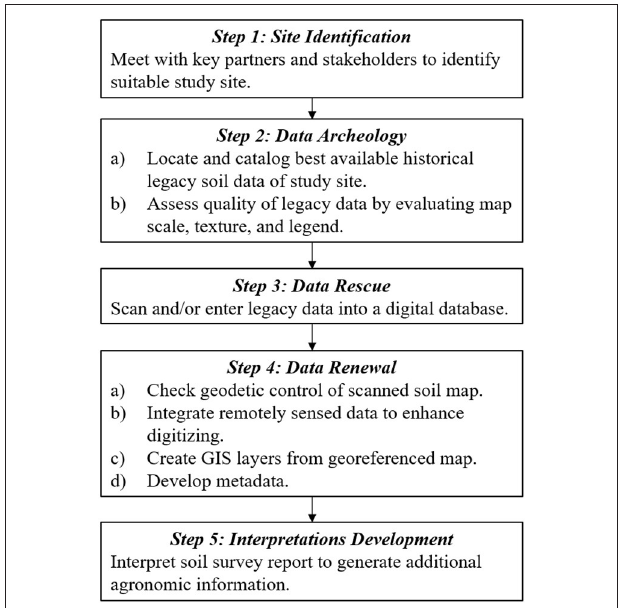
FIGURE 1 | Conceptual flowchart showing the stepwise process for renewing archival legacy soil